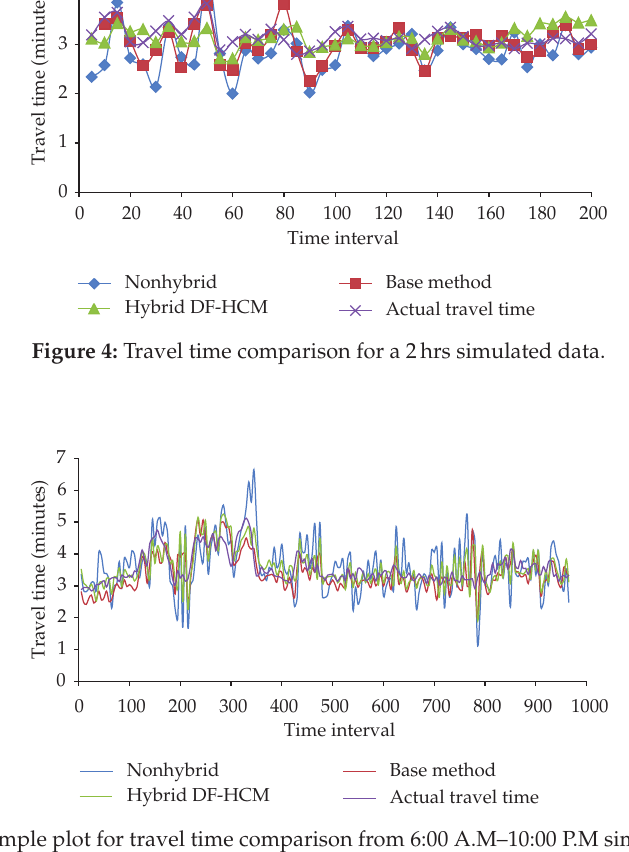
Figure 5: Sample plot for travel time comparison from 6:00 A.M–10:00 P.M simulated